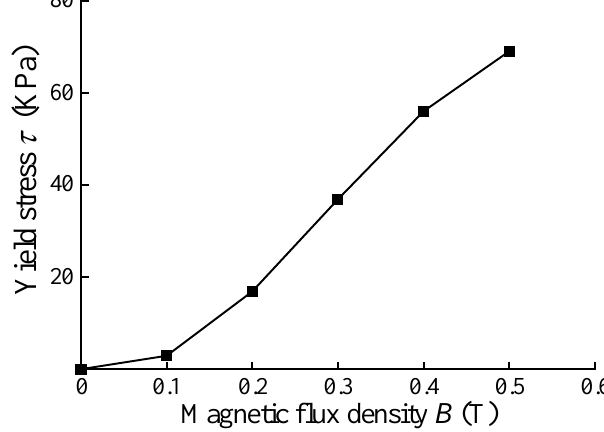
Figure 5. τ –B curve of MR fluid.